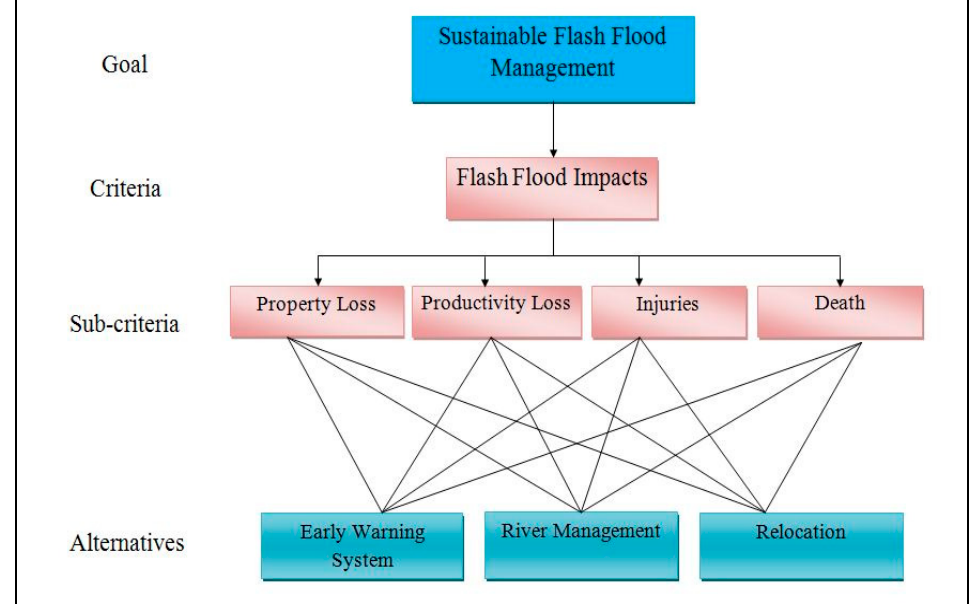
Figure 2. Analytic Hierarchy Process (AHP) model for sustainable flash flood management for